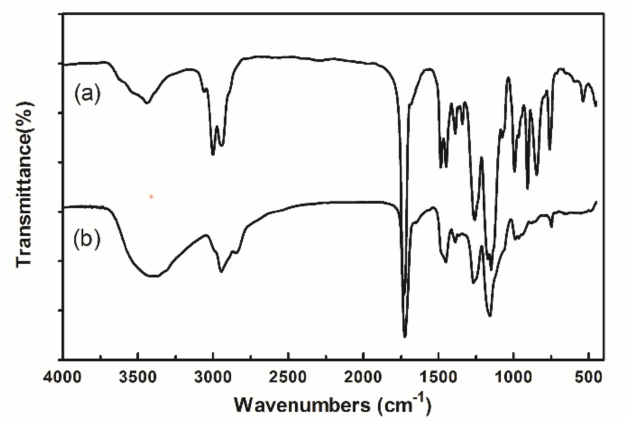
Figure 3. IR spectrum of microspheres. ( a ) PGMA microspheres. ( b ) Amino